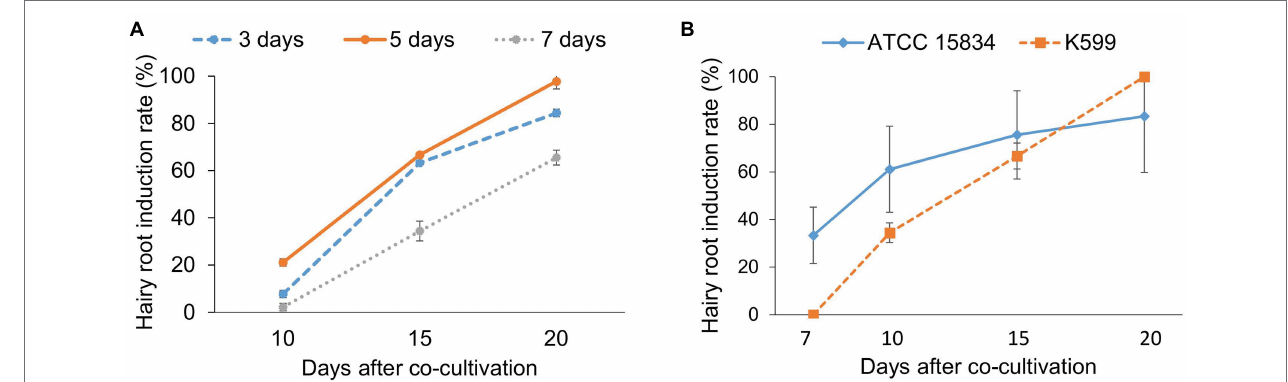
FIGURE 2 | The effects of co-cultivation duration and bacterial strains on cucumber hairy root induction. (A) Co-cultivation time and hairy root induction. (B) Rhizobium rhizogenes strains affect hairy root induction. Hairy root induction was observed and counted at different time points. Data are presented as mean ± SD of three replicates. About 30 explants were used for each